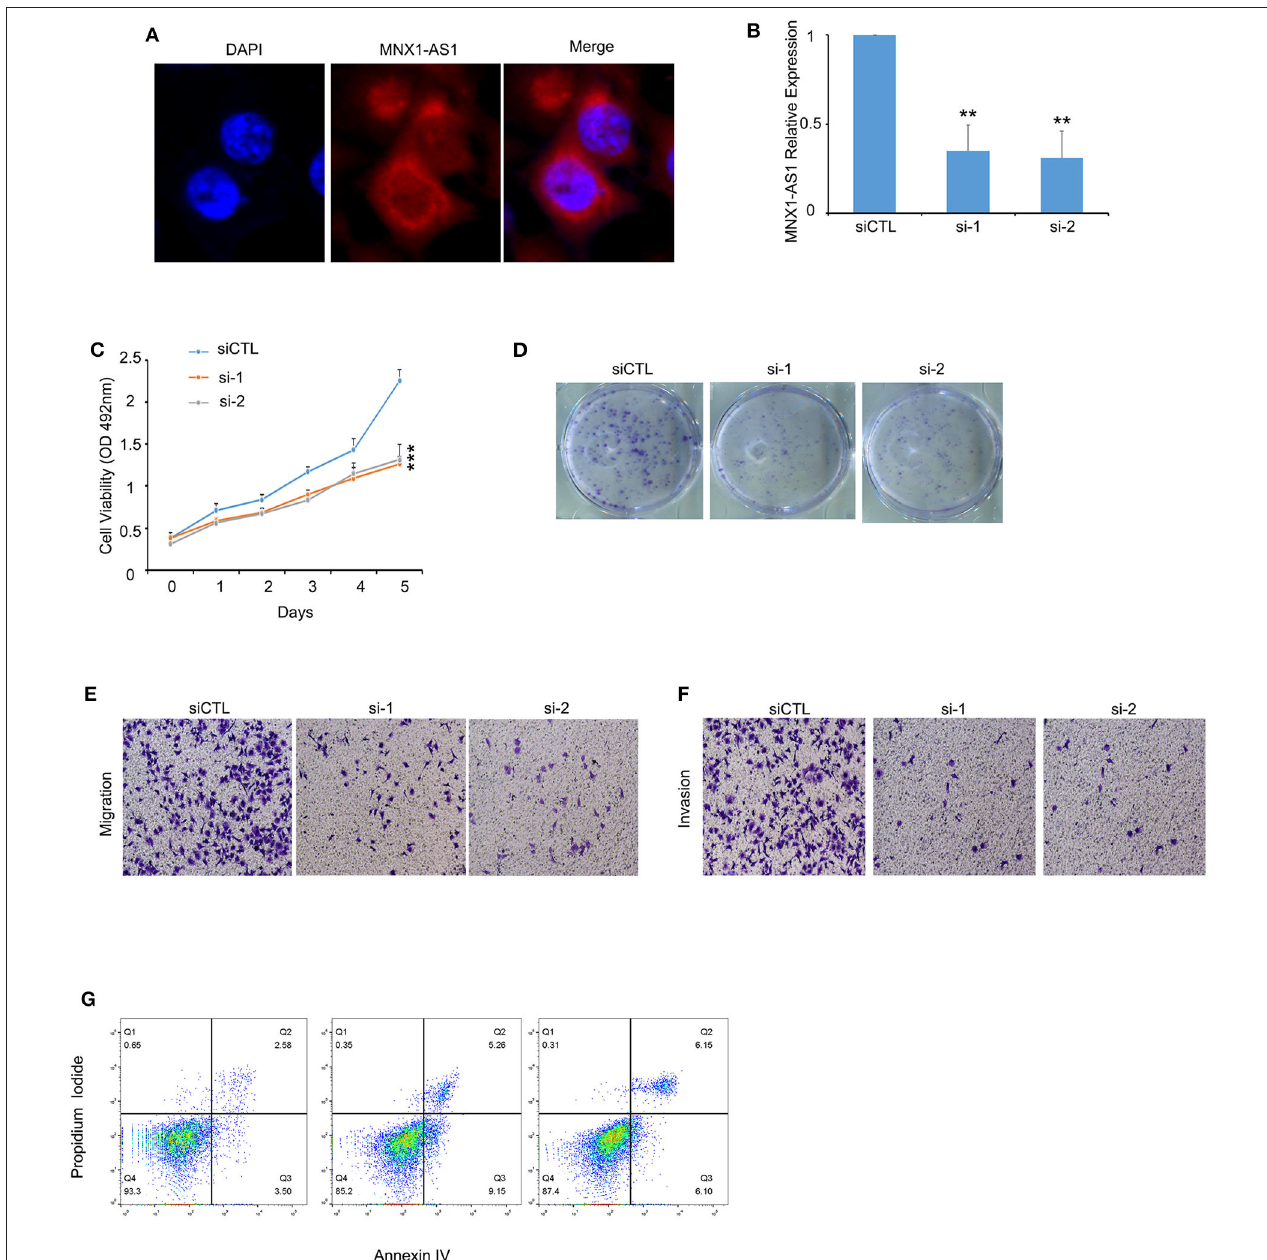
FIGURE 2 | MNX1-AS1 promotes progression of TNBC in vitro . (A) MNX1-AS1 mainly expressed in cytoplasm in MDA-MB-231, as indicated by Immunofluorescence. (B) Silencing efficacy of siRNAs (si-1 and si-2) to MNX1-AS1 were over 50% in MDA-MB-231. MNX1-AS1 expression was determined using qRT-PCR and normalized to siCTL expression. Bar graphs represent the mean ± SD of experimental triplicates. (C) Silencing MNX1-AS1 reduced viability of MDA-MB-231, as detected by MTS assay. Bar graphs represent the mean ± SD of experimental triplicates. (D) Silencing MNX1-AS1 reduced colony formation of MDA-MB-231. (E,F) Silencing MNX1-AS1 reduced migration and invasion of MDA-MB-231 cells. Culture inserts were coated with or without matrigel for the Boyden chamber assay of MDA-MB-231. (G) Silencing MNX1-AS1 induced apoptosis of MDA-MB231 cells. ** P < 0.01 and *** P < 0.001.